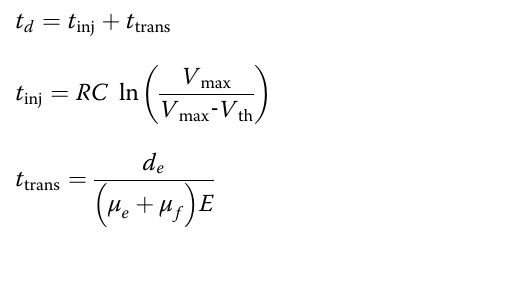
Performance Comparison Between Simple Trilayer and Multilayer OLEDs